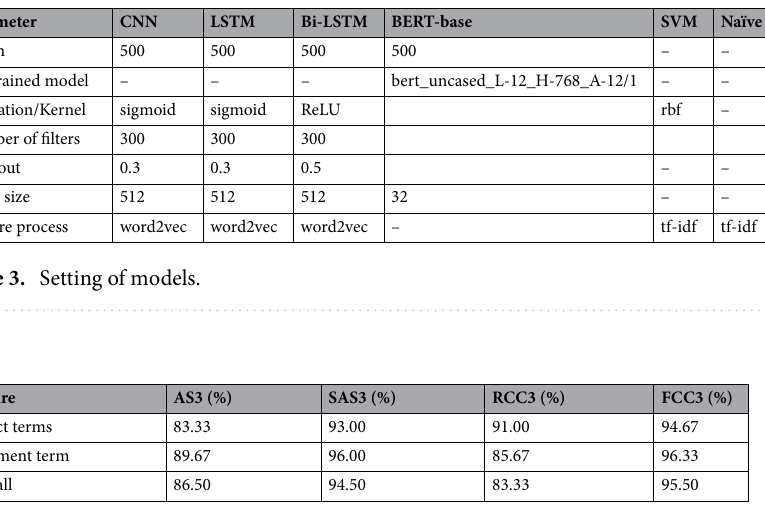
Table 4. The entity identity degree is closely related to the aspect or sentiment of the target word using the word2vec tool for datasets AS3, SAS3, RCC3, and FCC3.